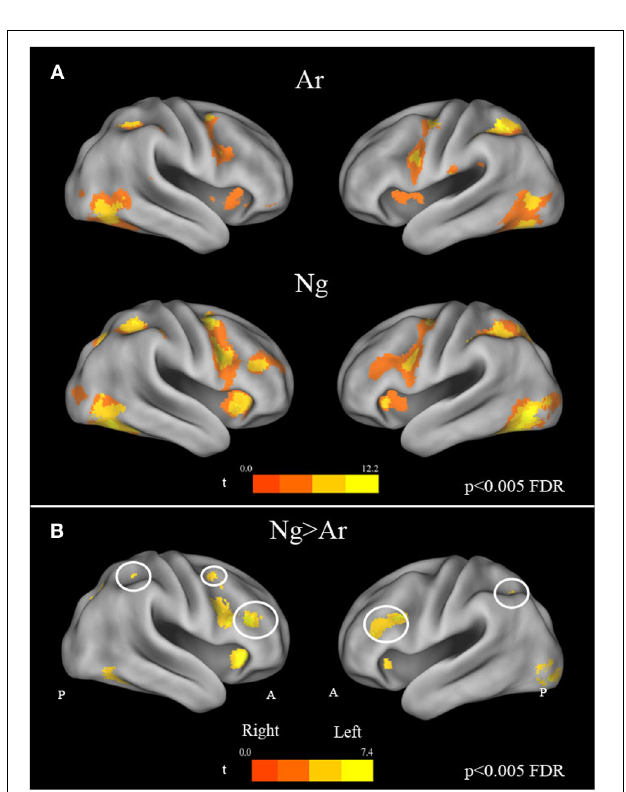
FIGURE 3 | Brain activation maps for Ar and Ng number identification tasks. Regions of activation in the brain for (A) Ar and (B) Ng tasks are shown as color coded brain maps (FDR p < 0 . 05).